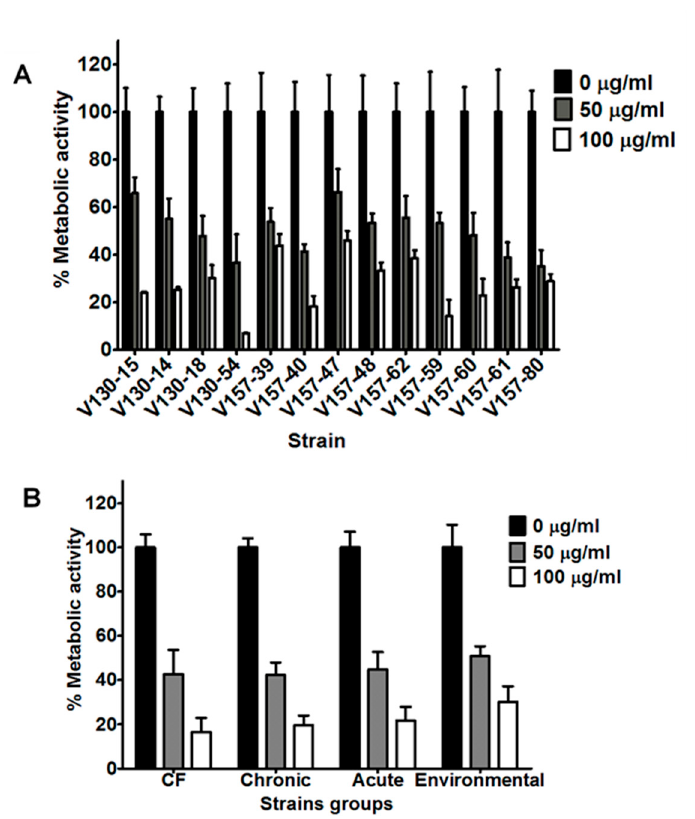
Figure 3. Antifungal activity of histones against a range of A. fumigatus isolates. ( A ) Metabolic activity of a series of isogenic isolates after 2 h incubation with histones (50 or 100 µg/mL). ( B ) Metabolic activity of strains of various clinical and environmental origins (data from 5 strains is combined into each group) after 2 h incubation with histones (50 or 100 µg/mL). Hyphae were grown overnight in RPMI and the media was refreshed prior to adding the peptide in phosphate buffered saline. Metabolic activity was determined by XTT assay. Data were obtained in two independent experiments, each with triplicate readings; mean values ± SD are shown.